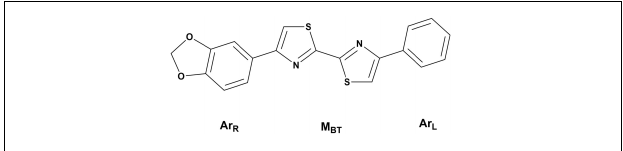
FIGURE 1 | The disarybisthiazole scaffold with a methylenedioxy group. other proteinopathies (PubChem, 2022; Niu et al., 2020). For sense to leave the methylenedioxy moiety constant in (Ar R ) and